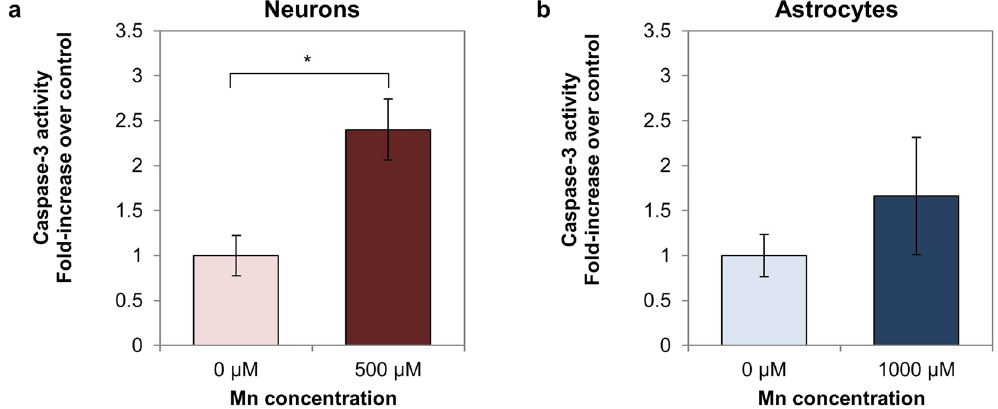
Figure 7. Caspase-3 activity in Mn-treated neurons and astrocytes vs. controls. ( a ) Caspase-3 activity in neurons is significantly elevated in the Mn-treated condition relative to the control. ( b ) Caspase-3 activity in astrocytes is slightly elevated relative to the control, but the difference is not statistically significant. * p <